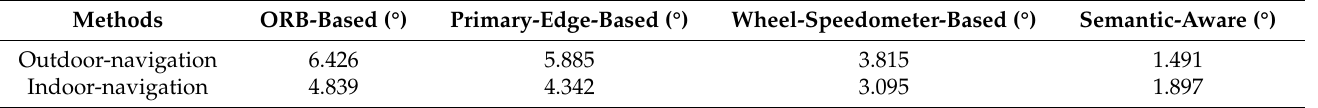
Table 2. Comparison of the orientation estimation errors of different